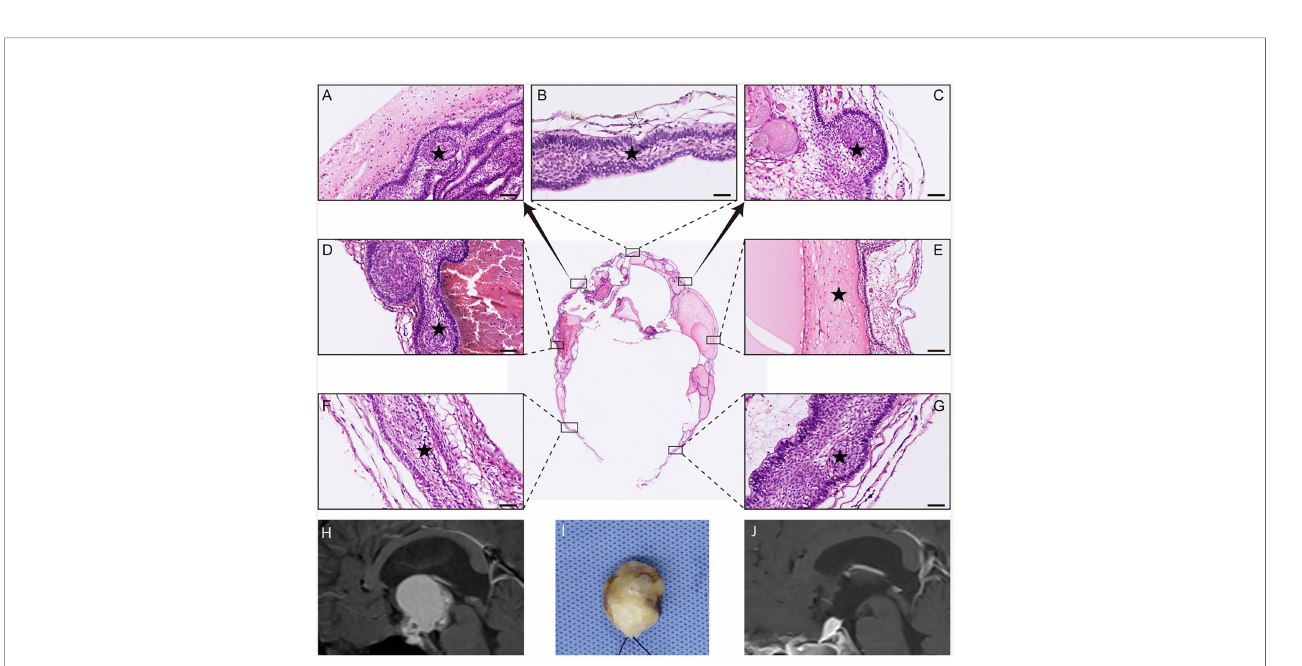
FIGURE 4 | Histological examination of a remodeling tumor with mainly ventricular involvement. In (A – G) , multiple portions of the tumor sample were stained with HE for histopathological examination. The result of HE staining shows that the whole tumor (black pentagram) was resected along either a dense band of gliosis or some membranous structures (white pentagram). In (H) , preoperative MRI indicates the tumor primarily involves the third ventricle. In (I) , the photograph showed the gross appearance of the remodeling tumor by packing with cotton after an en bloc tumor removal. In (J) , postoperative MRI demonstrates the total tumoral resection, and the hyperintense T1 signal represents the fat used for skull base